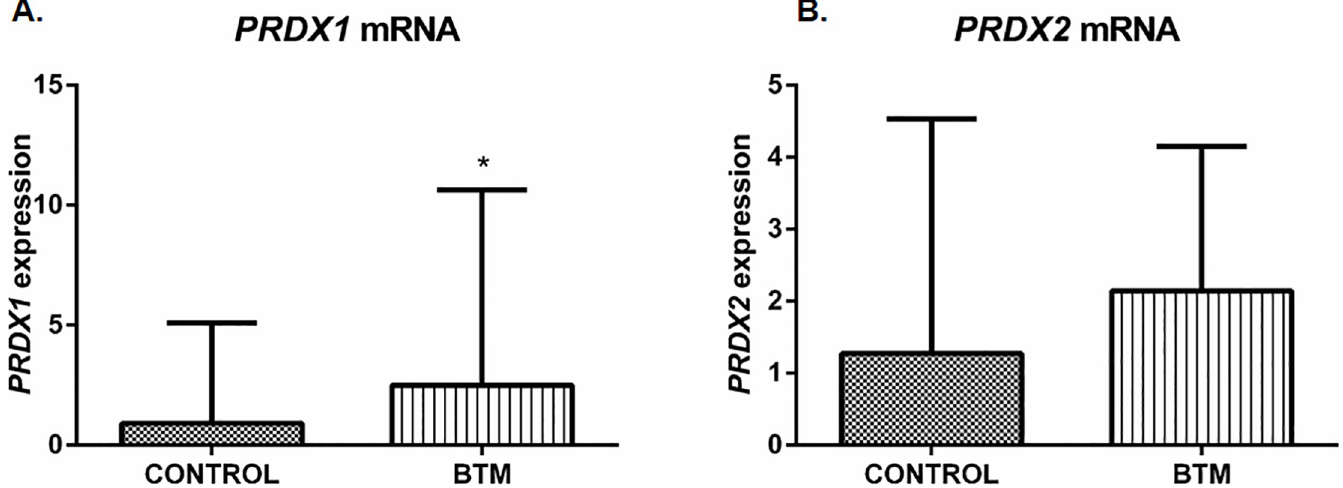
Fig 4. Transcription analysis of Prdx1 and Prdx2 gene expression in reticulocytes of BTI and BTM patients. RT-qPCR was carried out using the primers for each gene as described in S1 Table. mRNA abundance for each gene was normalized to Bac as endogenous reference. Results are presented as mean and standard error ( ± SEM). Statistical significance: � p < 0.05.